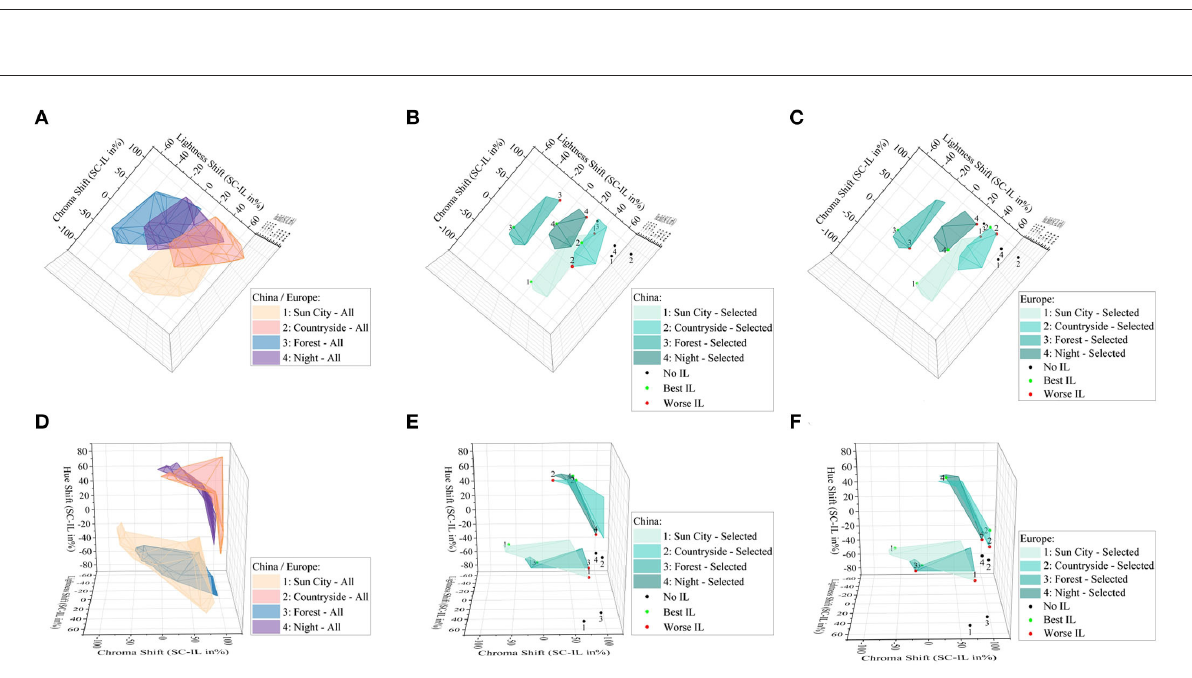
FIGURE7 (B,D) Primary boundary line, dashed purple, between exterior and interior. Highest LMS activation for exterior and interior marked in dashed blue. (A,B) Mixed CCT condition, L7, rated as good illumination in sun-city scenery and its LMS activation profile. (C,D) No in-vehicle lighting, which was worse rated. Primary LMS activation area is marked in blue for exterior and interior. Orange pixel blocks represent the outside scenery.